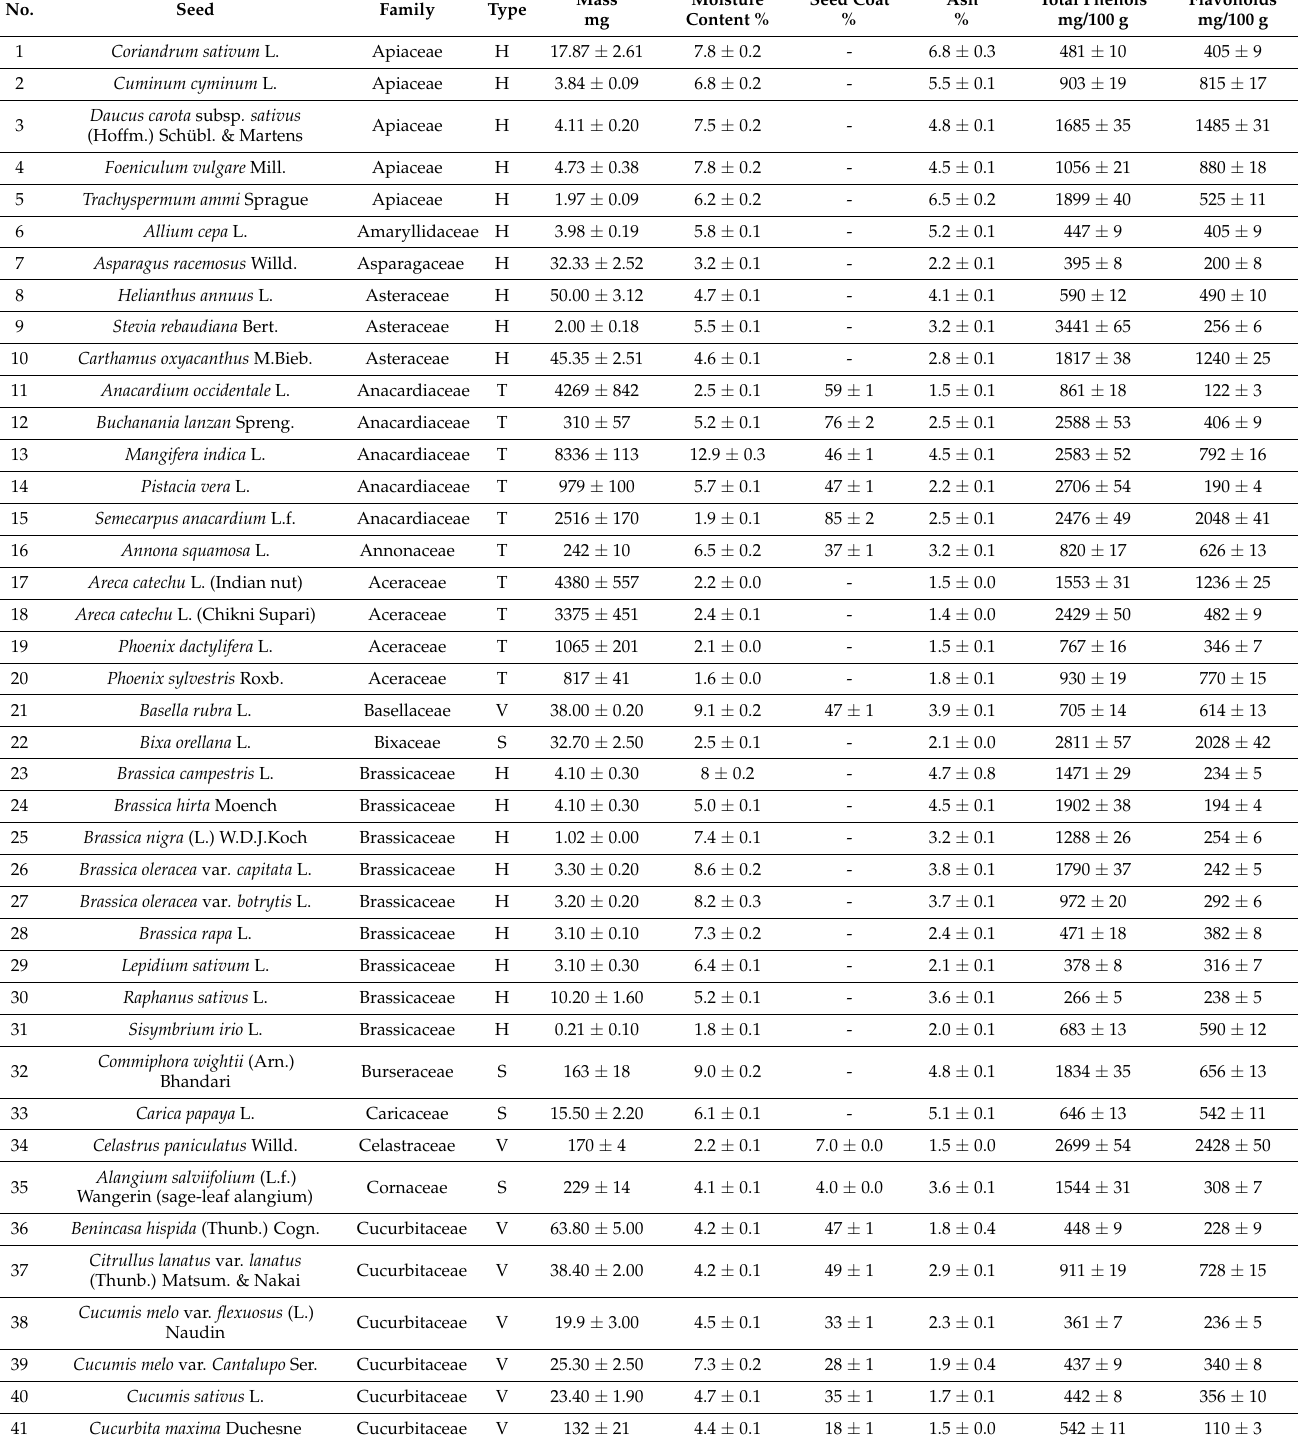
Table 1. Physicochemical characteristics and phenolic compounds of